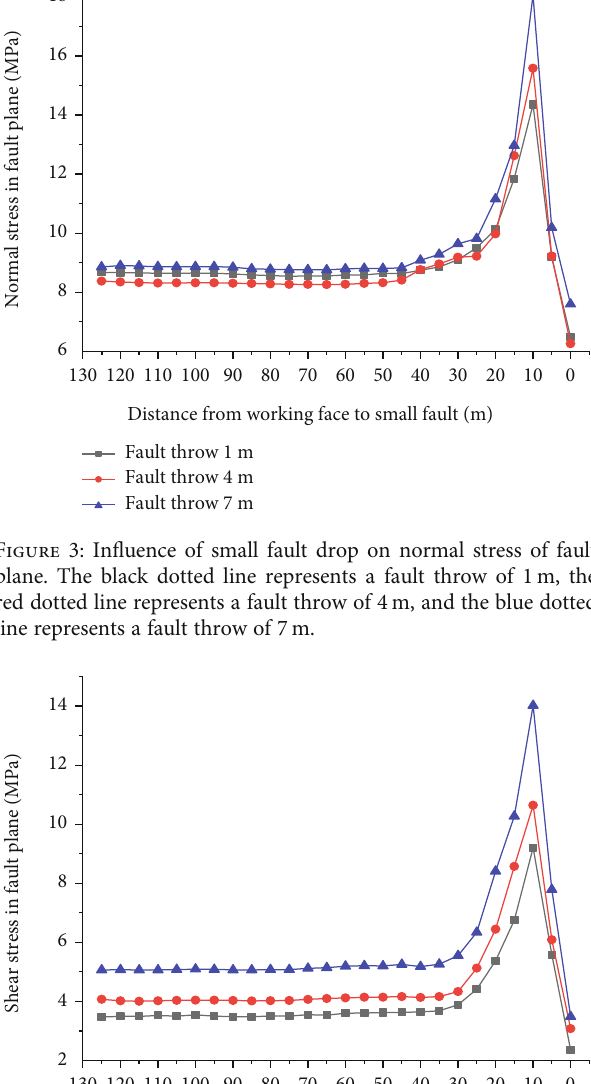
Table 3: Numerical simulation scheme.